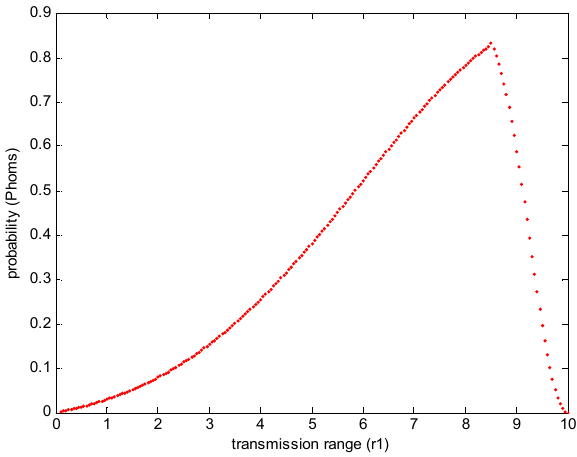
Figure 23. The probability under different transmission range in homogeneous networks.